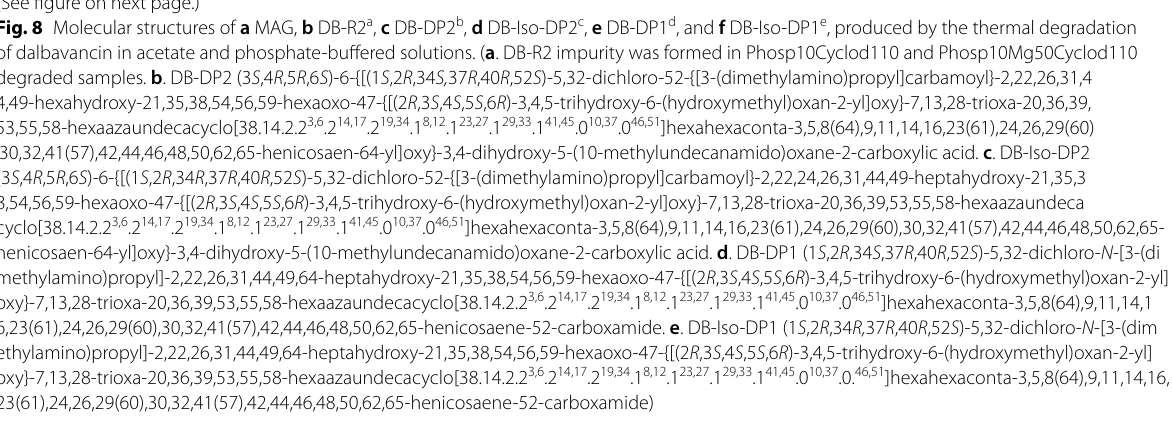
Fig. 8 Molecular structures of a MAG, b DB-R2 a , c DB-DP2 b , d DB-Iso-DP2 c , e DB-DP1 d , and f DB-Iso-DP1 e , produced by the thermal degradation of dalbavancin in acetate and phosphate-buffered solutions. ( a . DB-R2 impurity was formed in Phosp10Cyclod110 and Phosp10Mg50Cyclod110 degraded samples. b . DB-DP2 (3 S ,4 R ,5 R ,6 S )-6-{[(1 S ,2 R ,34 S, 37 R ,40 R ,52 S